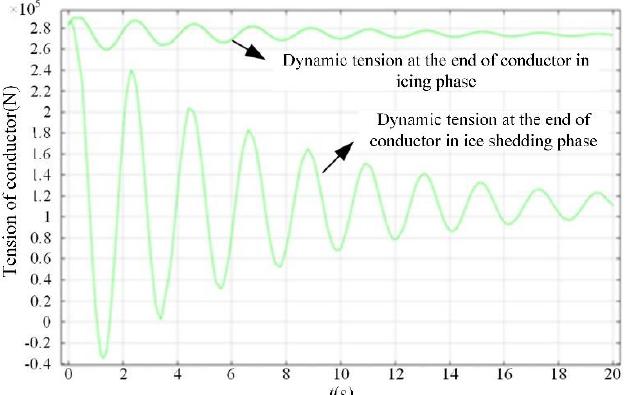
Figure 7. Dynamic tension changes at the end of the conductor.